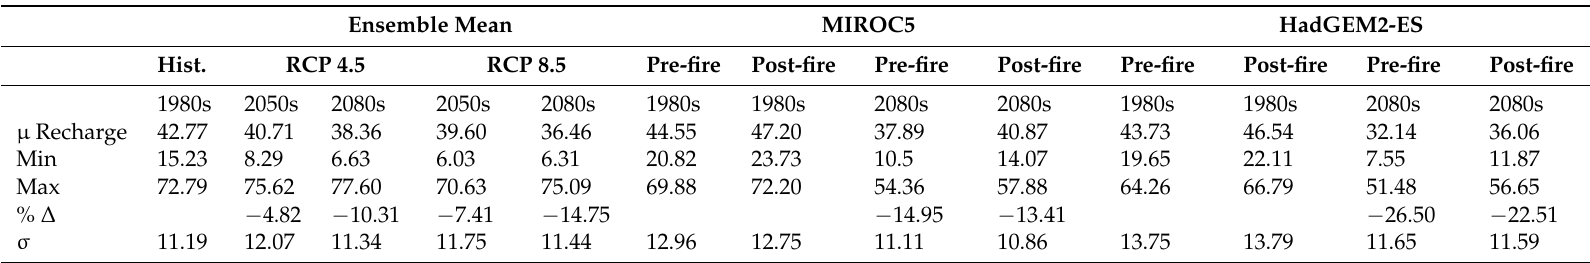
Table 7. Ensemble mean of potential basin recharge before forest cover reduction, and potential basin recharge before and after forest cover reduction in RCP 4.5 and RCP 8.5